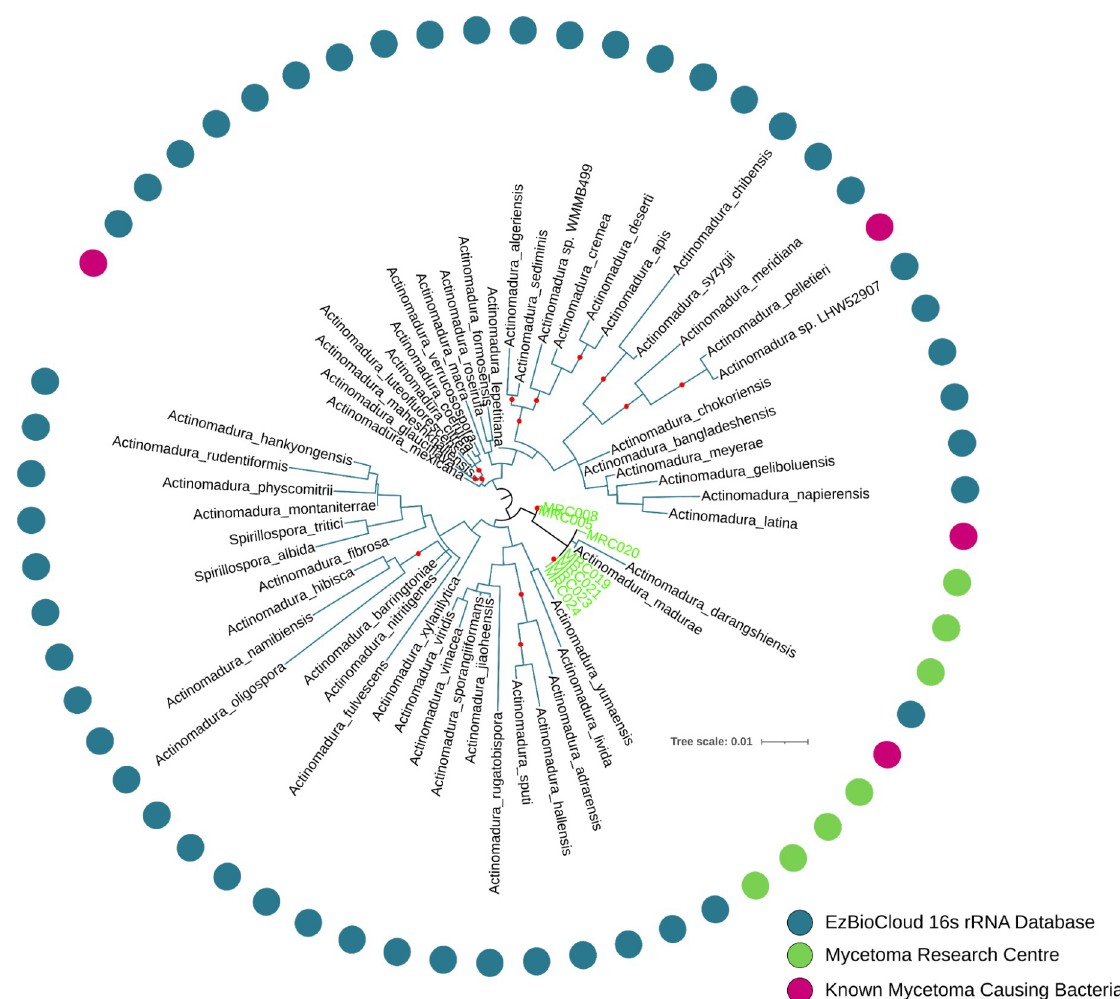
Fig 2. The 16S rRNA phylogeny of Actinomadura showing the placement of isolates (green) with related rRNA sequences from the ezBioCloud database (blue; pink for known pathogens). Inferred using iqtree2 and the GTR+F+R4 model. A black dot on branches indicates ultrafast bootstrap support > 95. All isolates form a clade with Actinomadura madurae and Actinomadura darangshiensis , though support for this grouping is low.